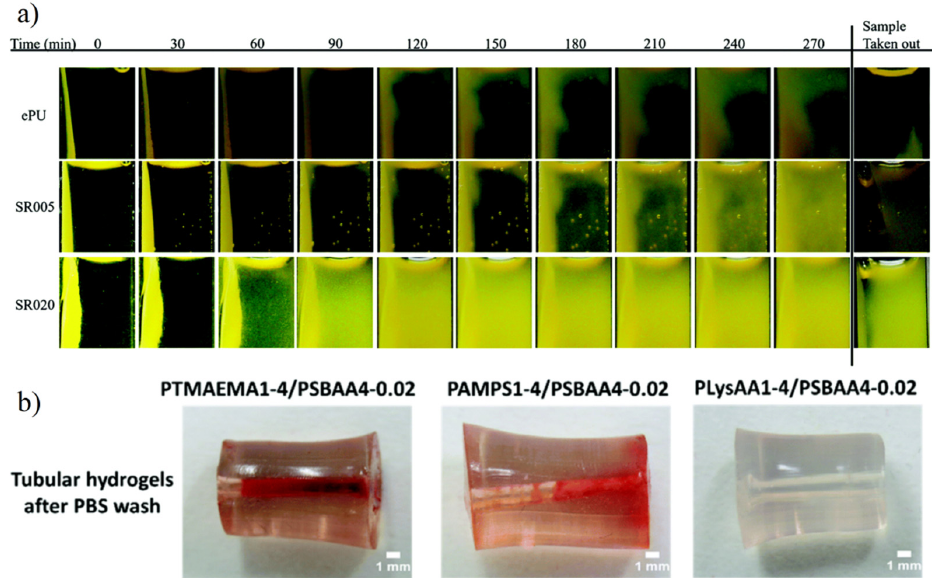
Figure 14. Anticoagulation performance of a zwitterionic hydrogel. ( a ) Time-lapse image of coagulation showed no interaction between electrospun reinforced zwitterionic hydrogel and fibrin network. Reproduced with permission from [50]. Copyright 2020 The Royal Society of Chemistry. ( b ) Anticoagulation and antithrombosis of tubular pLysAA/SBAA double network hydrogel. Reproduced with permission from [6] . Copyright 2020 The Royal Society of Chemistry.